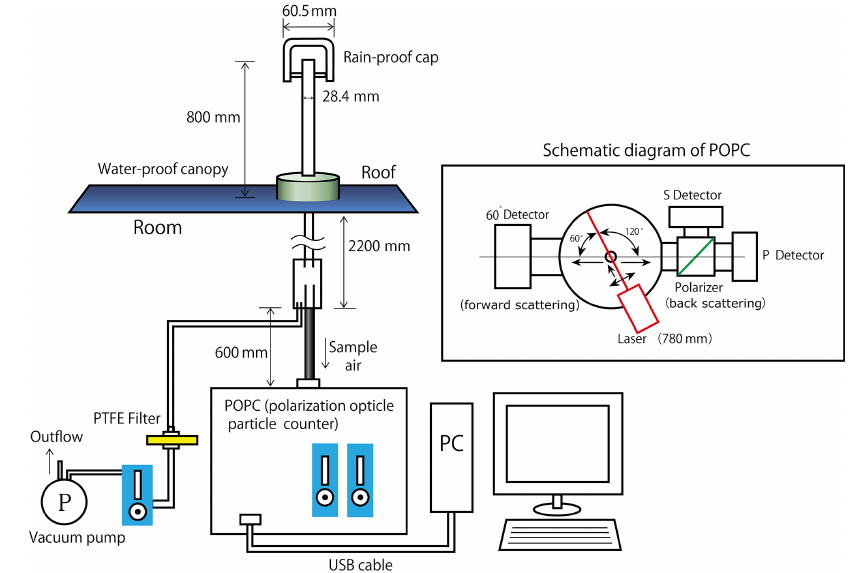
Figure 2. The layout of the instrument and schematic diagram of the polarization optical particle counter (POPC).